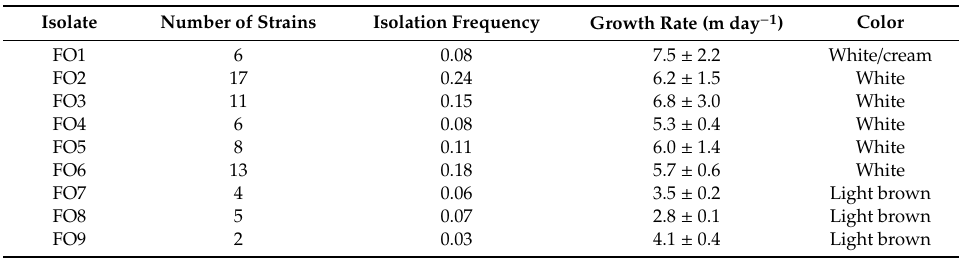
Table 2. Occurrence and morphological characteristics of the root fungal isolates associated to terrestrial orchids from the region of La Araucan í a, Southern